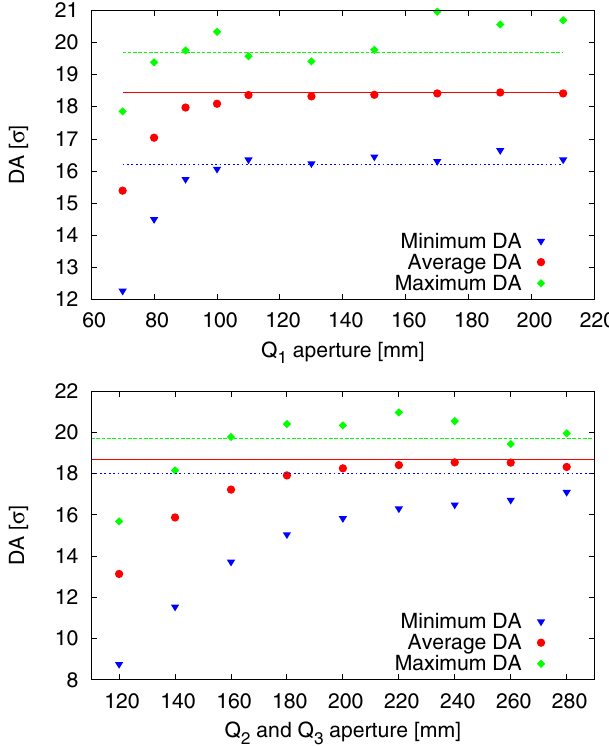
FIG. 4. (Color) DA as a function of the low-beta quadrupoles aperture. The scan over the aperture of Q 1 is shown in the upper plot (nominal aperture 150 mm), while Q 2 and Q 3 are considered in the lower plot (nominal aperture 220 mm). The layout is the so-called compact